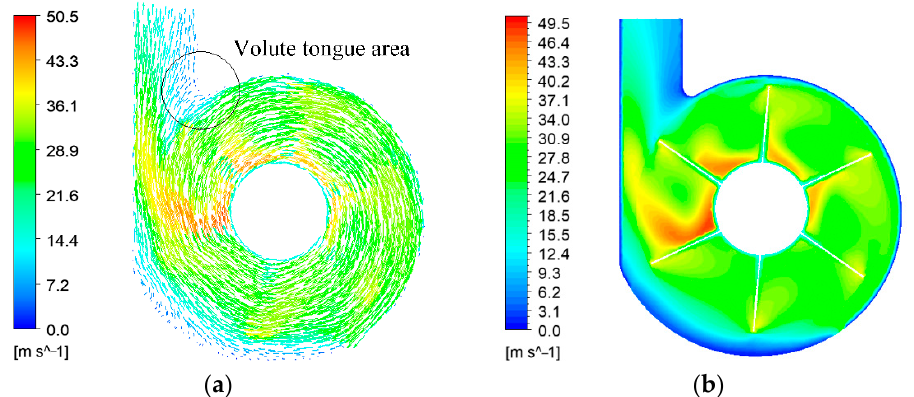
Figure 10. Velocity vector diagram of cross section 3 ( a ) and velocity nephogram of cross section 3 ( b ).